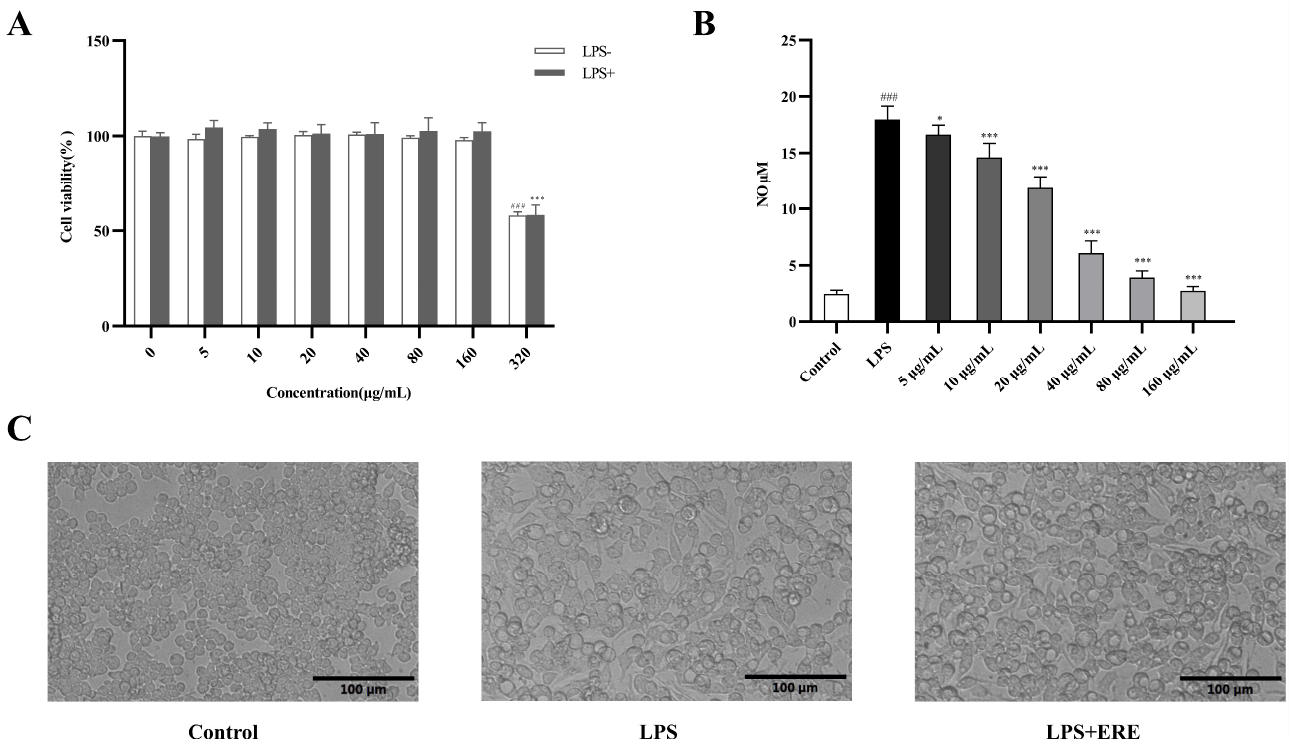
Figure 4. The effects of ERE on cell viability ( A ), NO production ( B ) and cell morphology ( C ) in LPS-induced RAW 264.7 cells. Scale bar = 100 µ m. The values are expressed as the mean ± S.D: * p < 0.05 compared with LPS group; *** p < 0.001 compared with LPS group; ### p < 0.001 compared with control group.